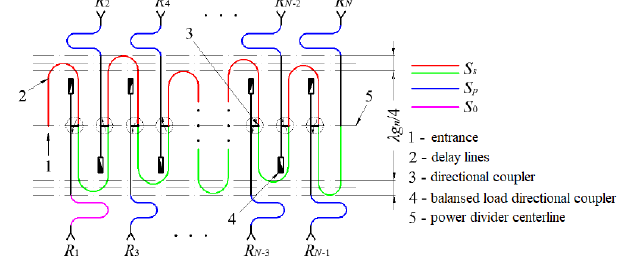
FIGURE 16. Structural diagram of an antenna array with serial-parallel power supply of emitters.